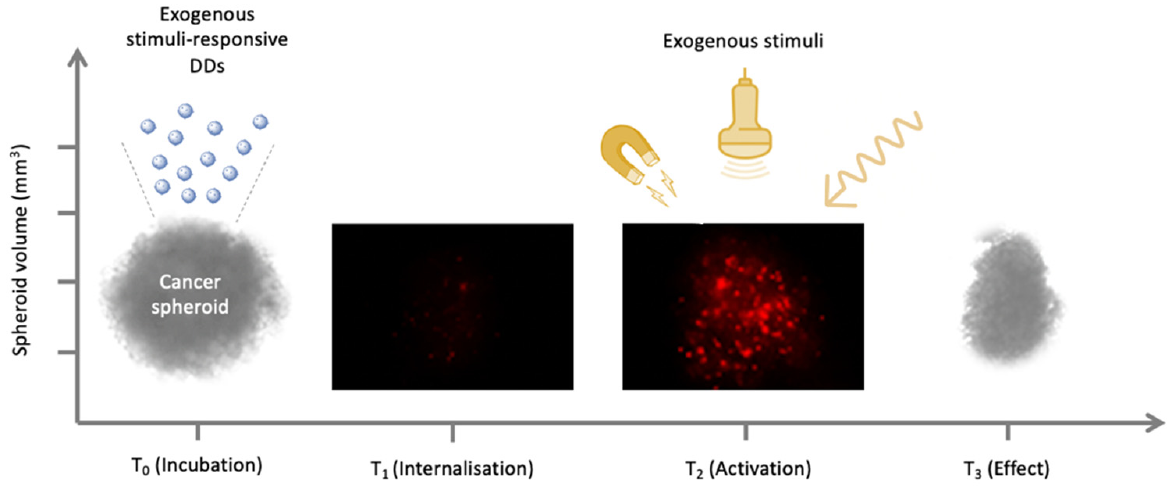
Figure 2. Exogenous triggers for time and site-specific delivery of drugs by stimuli-responsive drug-delivery systems.